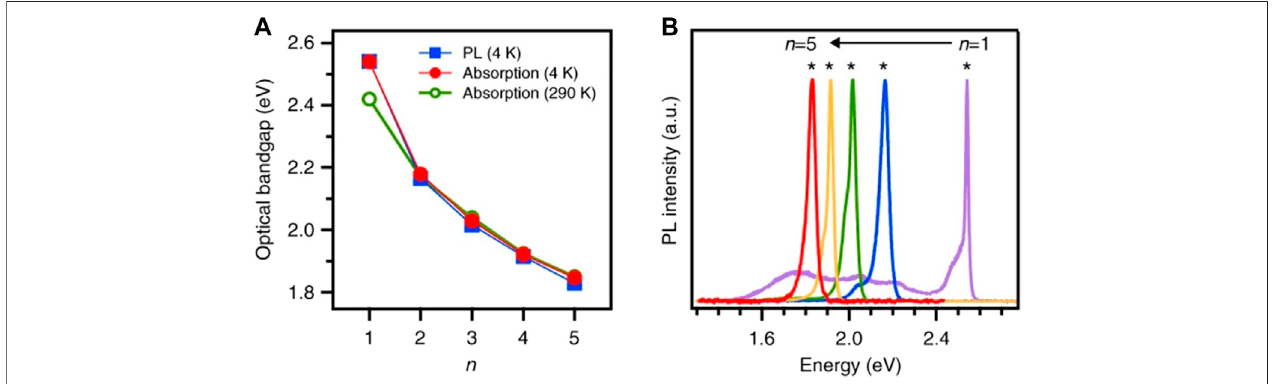
FIGURE5| Opticalspectroscopy,PL(at4 Kbluesquaresymbolandline),andabsorptionspectra(at4 Kredand290 Kgreenclosedandopenedcircle)oftheRP perovskite crystals with n (cid:1) 1 – 5. (A) Scaling of experimentally obtained optical bandgap. (B) Photoluminescence spectra. The fi gure is reprinted with permission